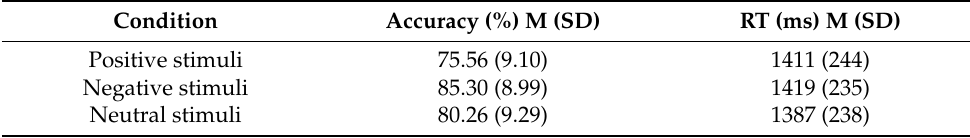
Table 1. Mean response accuracy and RT in different